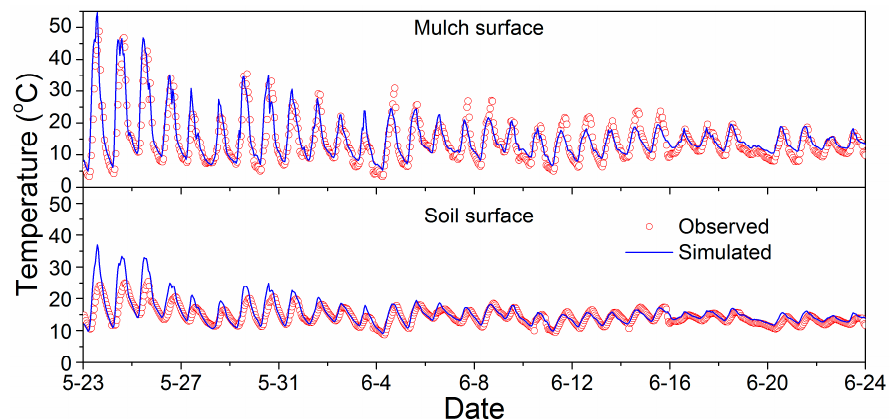
Figure 8. Comparison of the observed and simulated hourly temperature on the black plastic film mulch (BM) surface and soil surface at Wuwei, China, in 2015. Table 4. The root mean square errors (RMSE), coefficient of determination ( R 2 ), and mean errors (ME) in simulated and observed hourly temperatures on the mulch surface and soil surface for